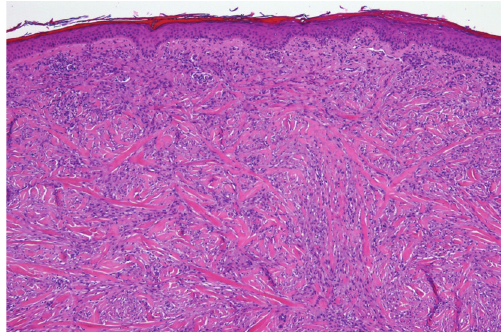
Figure 2: Desmoplastic melanoma: atypical spindle cells in a dense fibous matrix (haematoxylin and eosin; original magnification × 10).